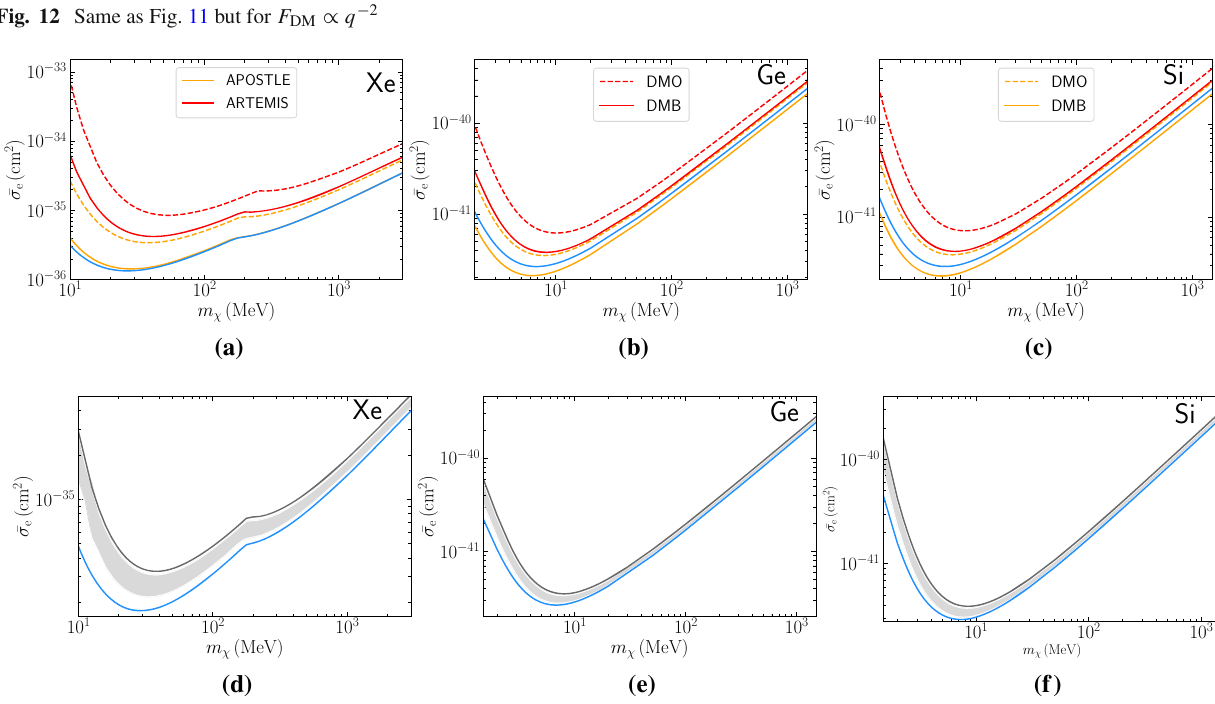
Fig. 13 Shifts in the exclusion limits for Tsallis distribution with F DM ∝ q − 1 . In the upper panel we show the variations for the best fit values of different cosmological simulations. The bands in the lower